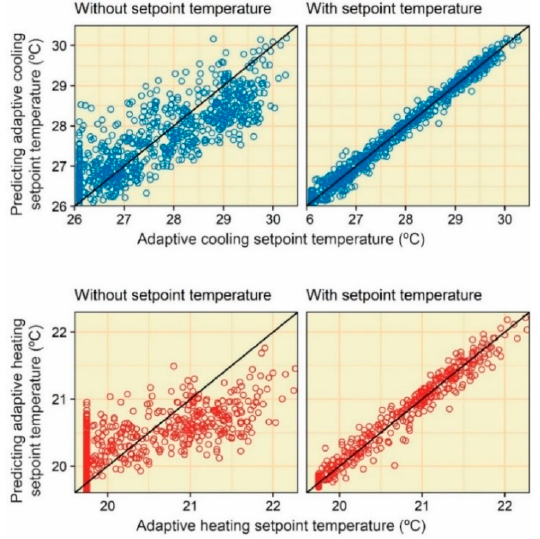
Figure 6. Influence of applying the setpoint temperature from the previous day on the MLR by using the external temperature of the weather station of Xesteiras. Energies 2019 , 12 , x FOR PEER REVIEW